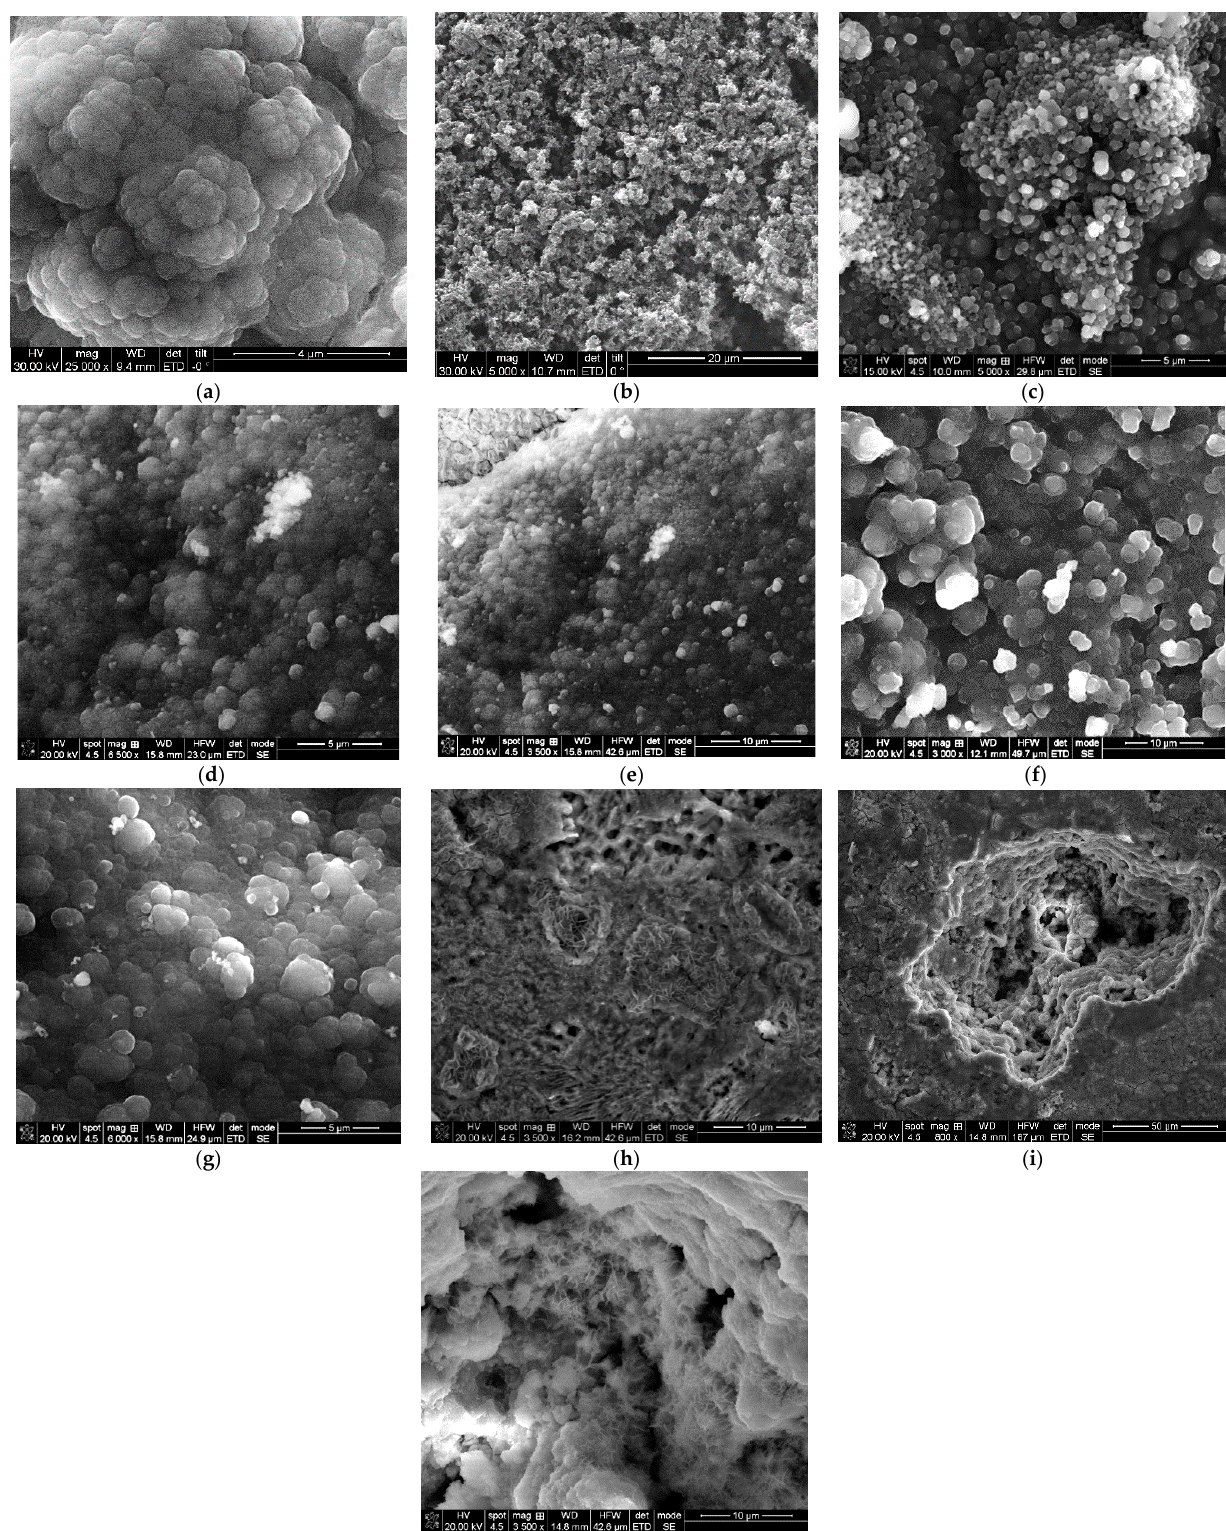
Figure 12. SEM images of OL 37 electrode coated with ( a ) PNMPY-TRX100/OL37, ( b ) PNNDEA/OL37, ( c – g ) PNMPY- TRX100/PNNDEA/OL37 at 3 mA/cm 2 , 5 mA/cm 2 and 8 mA/cm 2 in 5:1, 3:2 molar ratios and ( h – j ) after 96 h, 144 h, and 168 h immersion period in 0.5 M H 2 SO 4 .